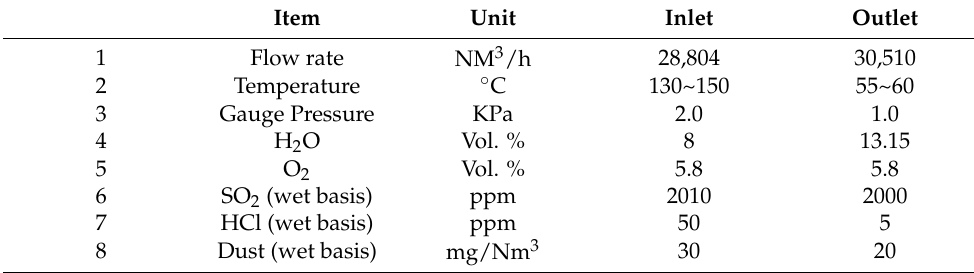
Figure 2. The pilot plant for the concentrating process test. Table 1. Characters of flue gas in the concentrating scrubber inlet and outlet.